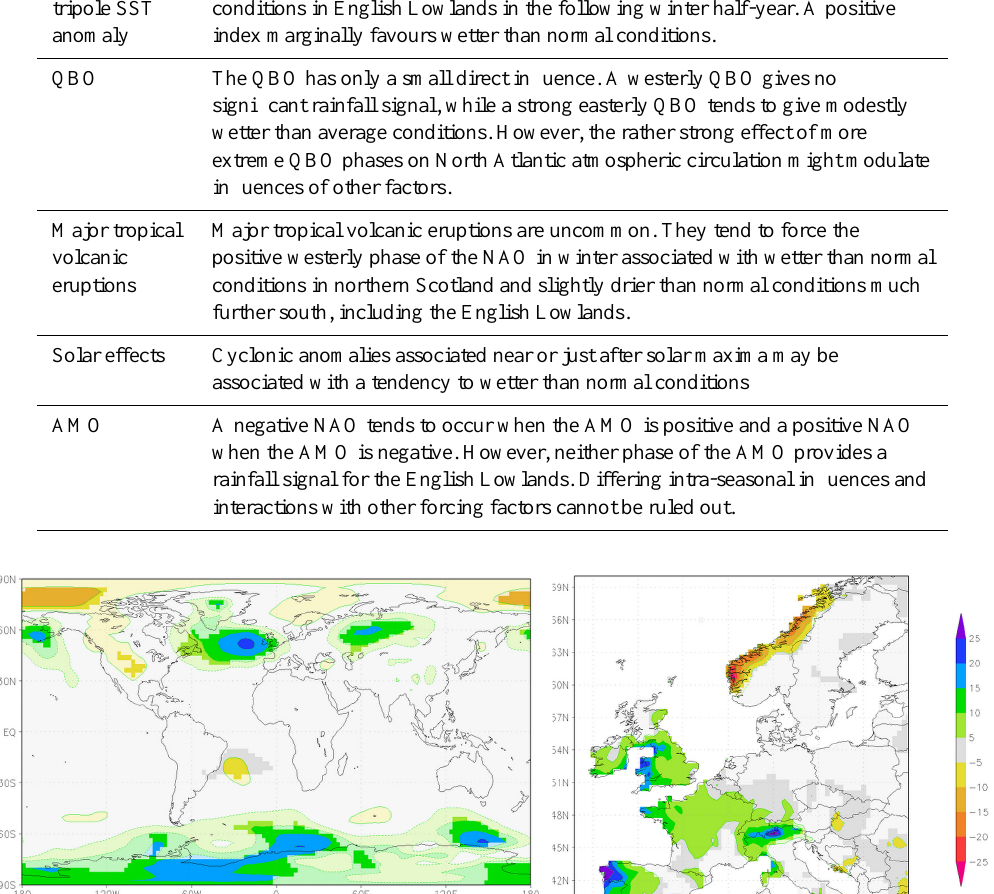
lies for the winter half-year lagged by 1 year on average com- pared to the highest 20 % of values of TSI over